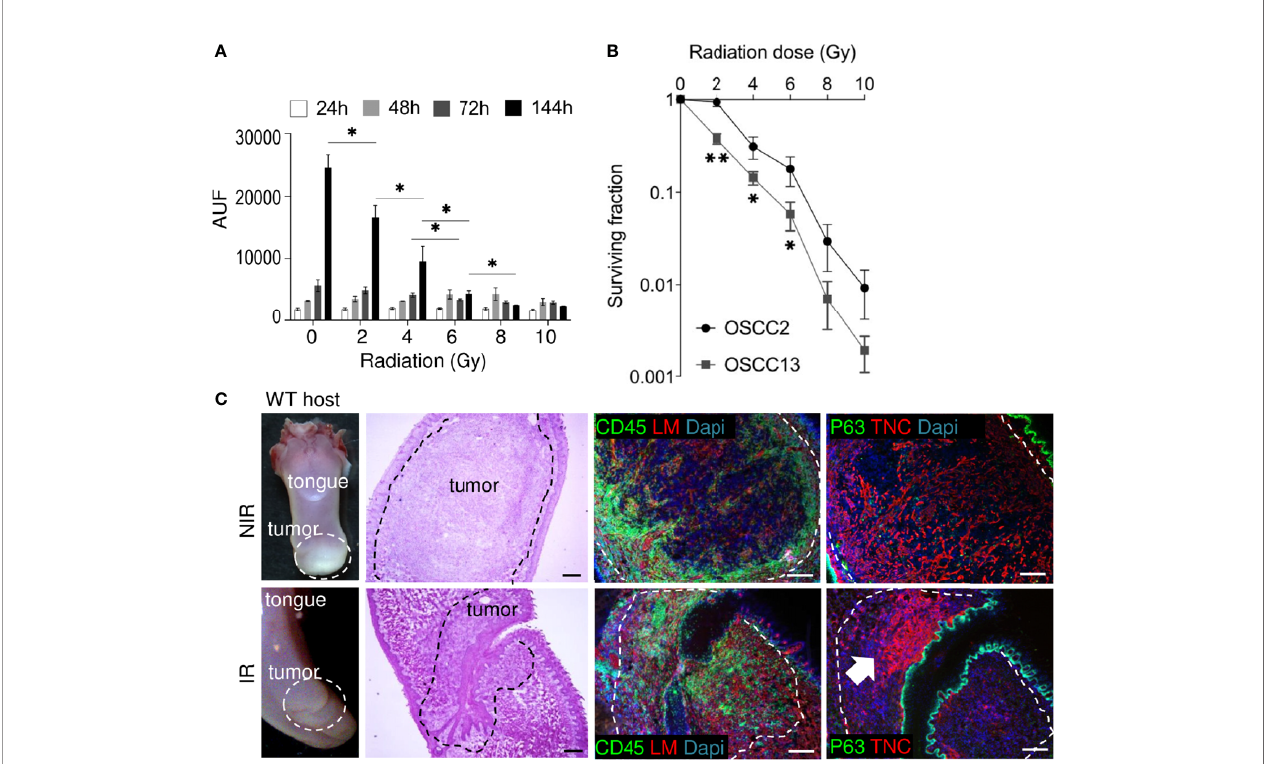
FIGURE 5 | Impact of irradiation on cultured OSCC13 cells and tumors. (A) OSCC13 cell proliferation upon exposure to the indicated irradiation doses after the indicated time points (hours, h) using a resazurin assay. Data are represented as mean ± SEM of at least three independent experiments. Student – Newman – Keuls test. *p < 0.05. (B) Clonogenic survival assessment upon exposure to the indicated irradiation doses. The surviving fractions are represented. Mean ± SD of four independent experiments. ANOVA test. **p <0.001, *p < 0.005. (C) Representative (N = 5) macroscopical images of H&E stained tongue tissue from OSCC13 tumors in a WT host and upon immunostaining with speci fi c antibodies against laminin (LM, red) or TNC (red) together with CD45 (green)or p63 (green). Scale bar, 100 µm. Arrow points at dense TNC matrix seen upon irradiation. IR, irradiated; NIR,